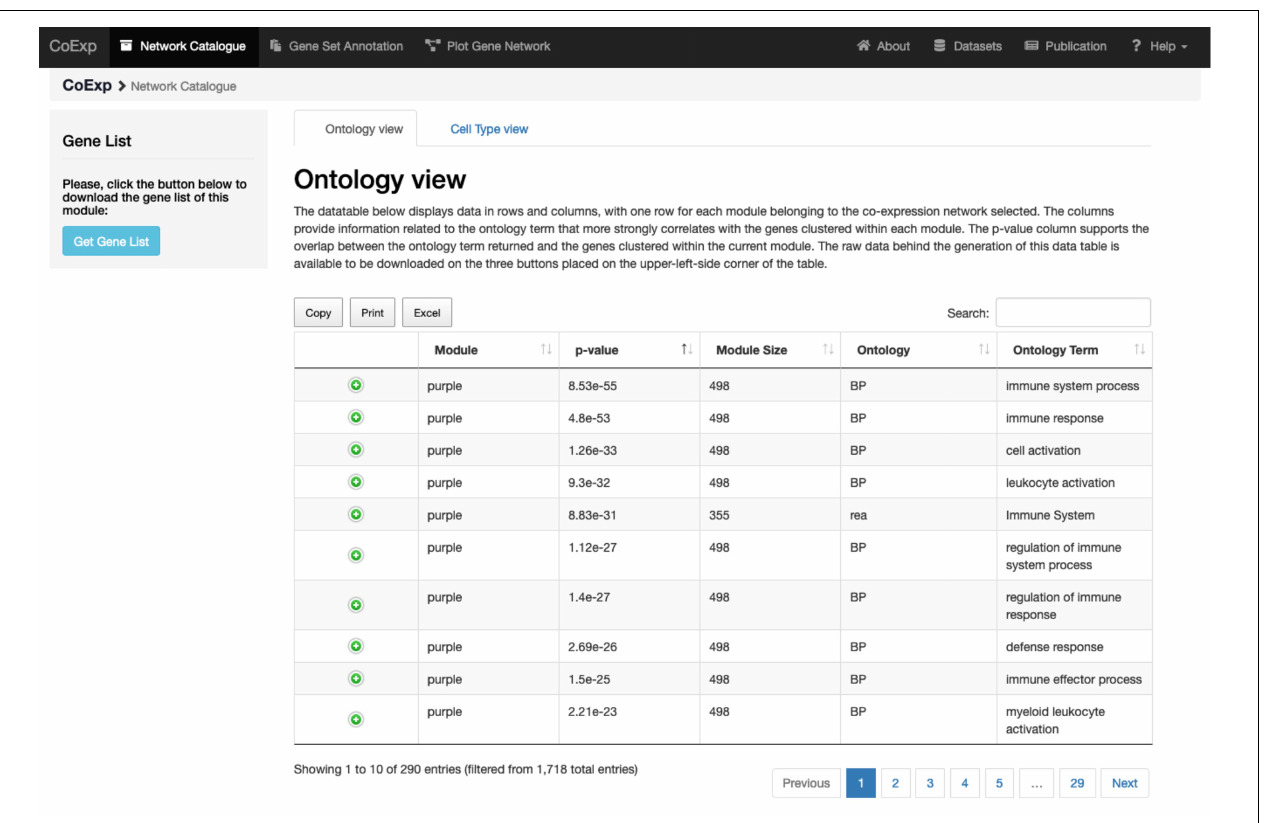
FIGURE 4 | Investigating a module of interest. By clicking on a module of interest, such as the purple module link, the user obtains a table with all the purple module-specific information on functional annotation. All annotations can be downloaded in the form of an Excel file for later inspection.